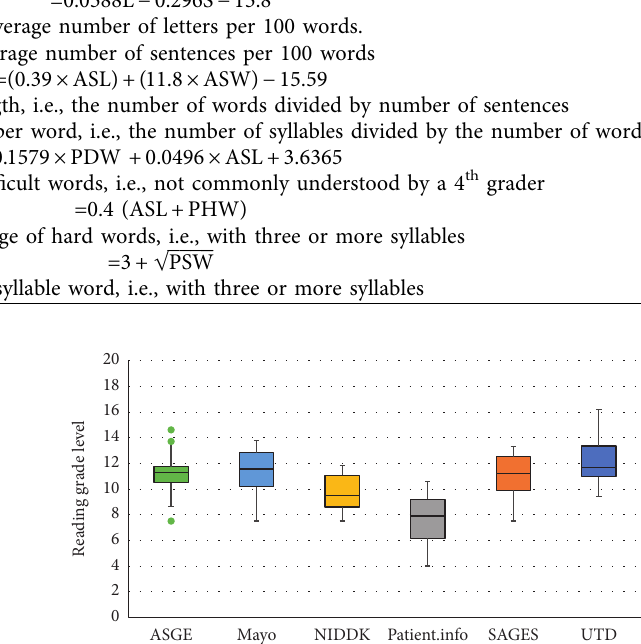
Figure 2: Box and whisker plot analysis of the EGD reading material. The American Society for Gastrointestinal Endoscopy (ASGE) had a median of 11.3 (minimum-maximum of 7.5–14.6), Mayo Clinic scored a median of 11.6 (7.5–13.8), the National Institute of Diabetes and Digestive and Kidney Diseases (NIDDK) scored a median of 9.5 (7.5–11.8), Patient.info had a median of 7.9 (4–10.6), the Society of American Gastrointestinal and Endoscopic Surgeons (SAGES) scored a median of 11.2 (7.5–13.3), and finally UpToDate Beyond the Basics (UTD) had scored a median of